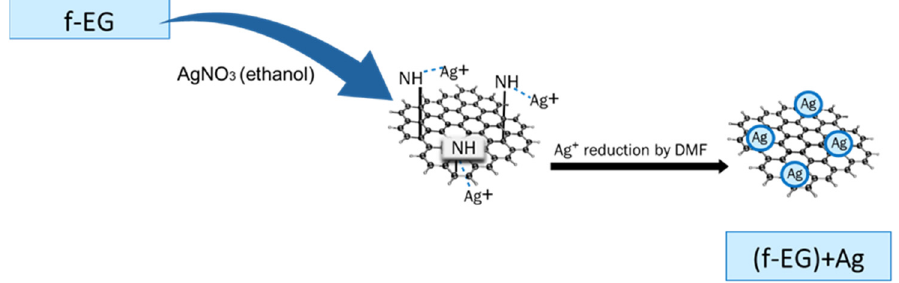
Figure 3. Schematic representation of the EG functionalization by the DCA reaction, obtaining f- EG as well as its further interaction with PLA under melt processing conditions.